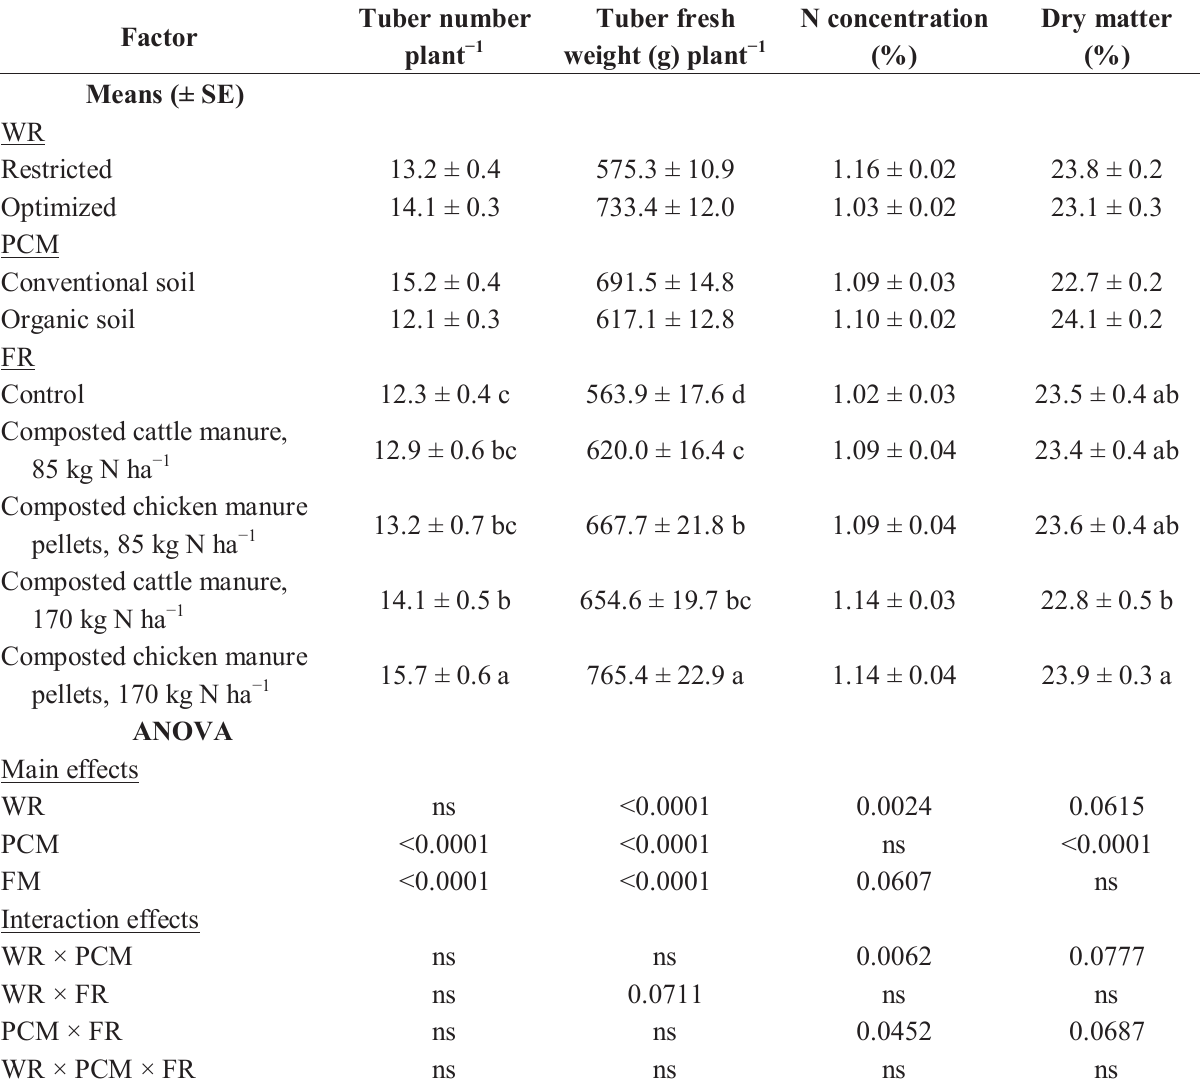
Table 3. Effects of previous crop management (PCM), fertilization regime (FR), and watering regime (WR) on total tuber yield, and tuber N